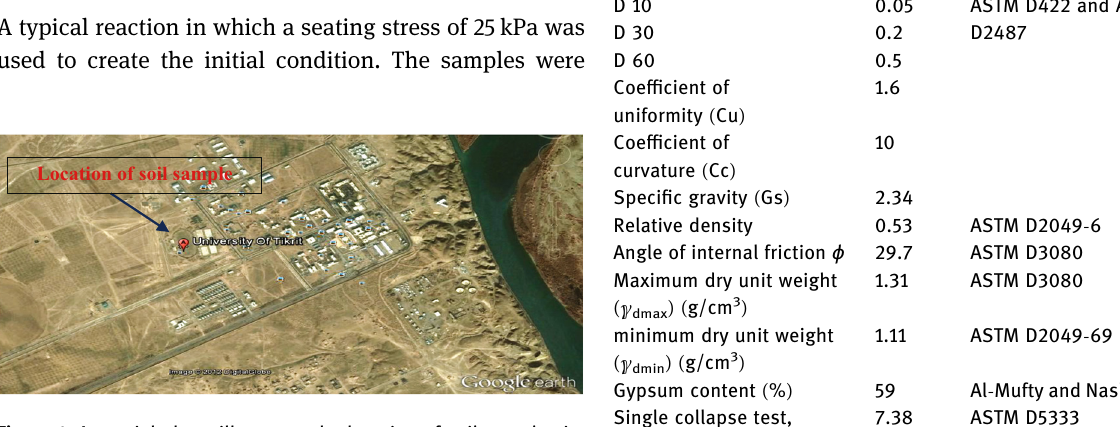
Figure 1: An aerial photo illustrates the location of soil samples in Salah El - Deen governorate/Iraq.